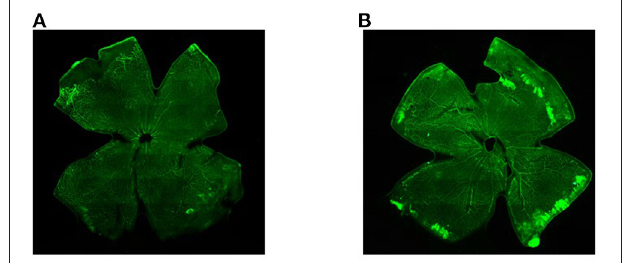
FIGURE 1 | The number of retinal vessels in the hyperoxia group increased. HE staining showed retinal vessels in the air group (A) and hyperoxia group (B) (200X). The red arrow represents the retinal hyperplastic capillary plexus.